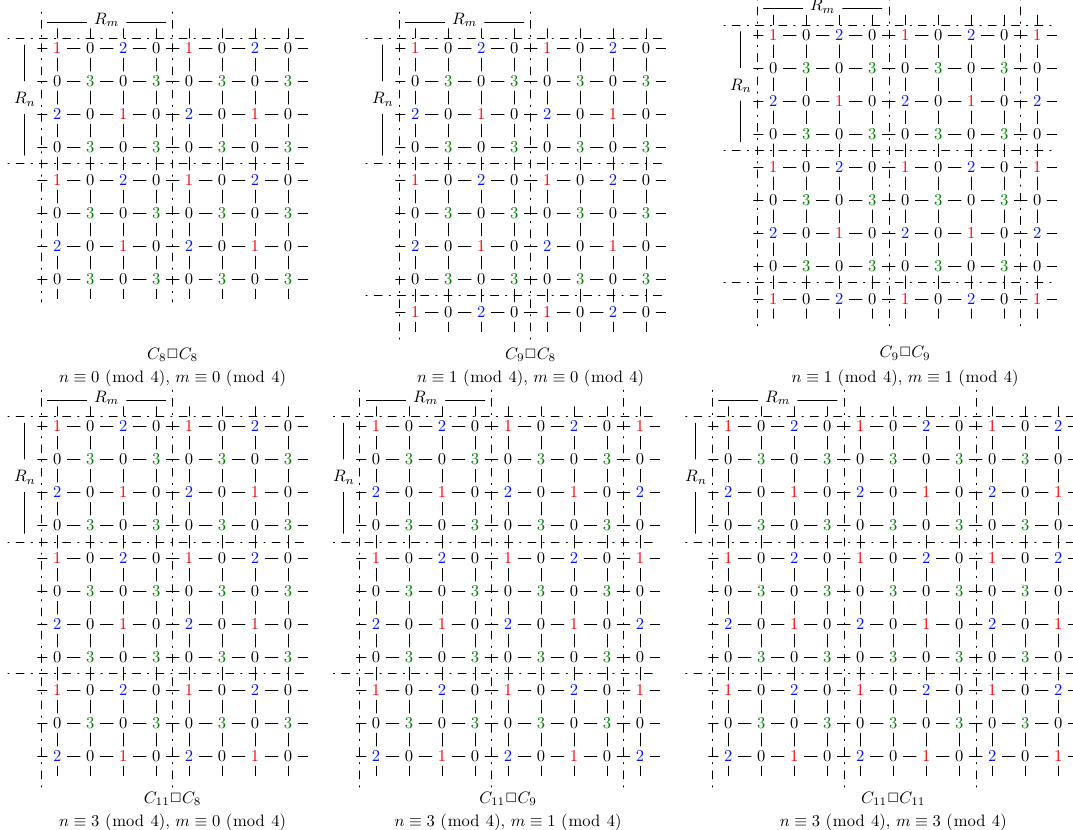
2 ( mod 4 ) 2 ( mod 4 ) ̸≡ (cid:54)≡